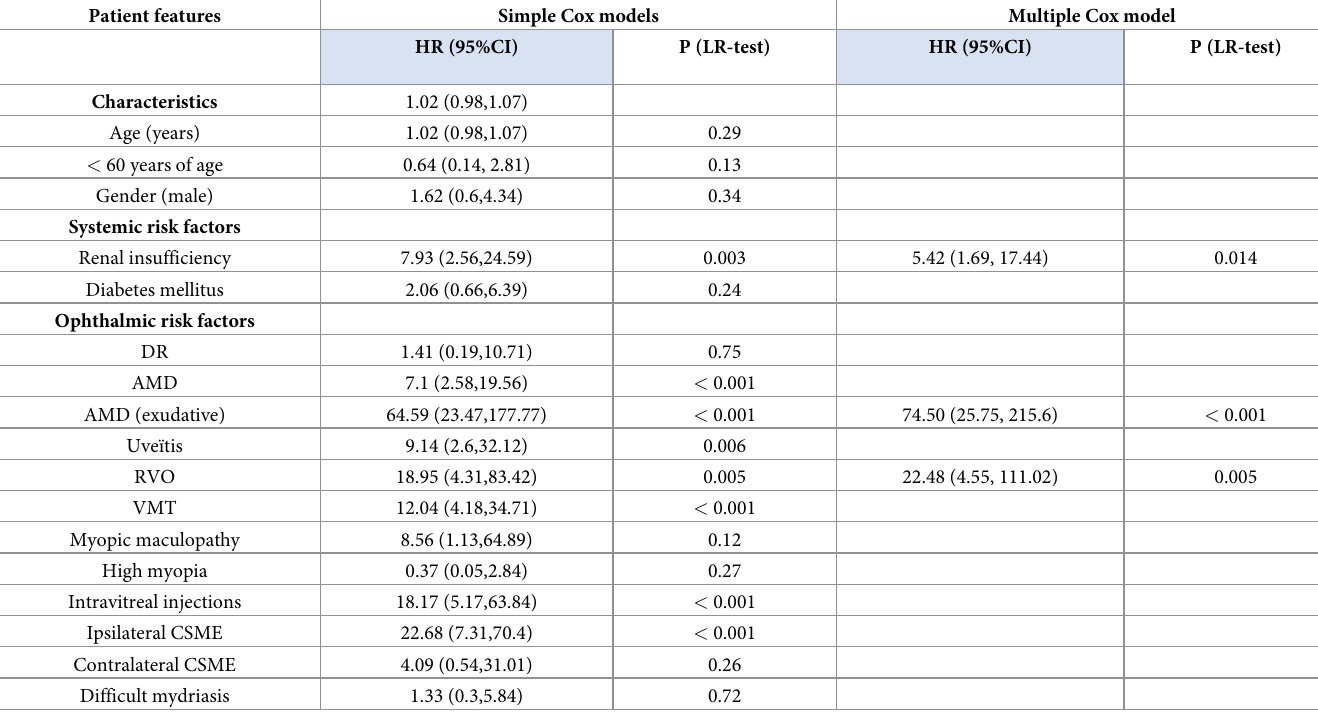
Table 3. Simple and multiple Cox models for CSME and CSPME after BIL